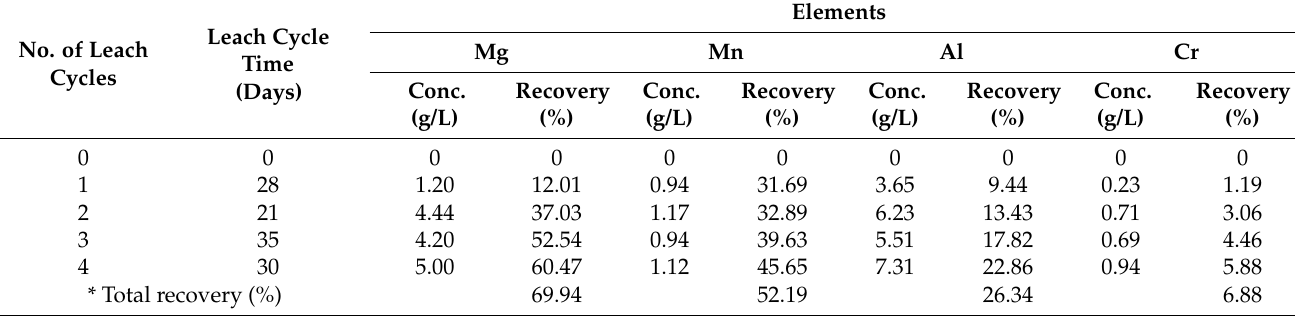
Table 5. Analysis of the pregnant solution and percent extraction of metal